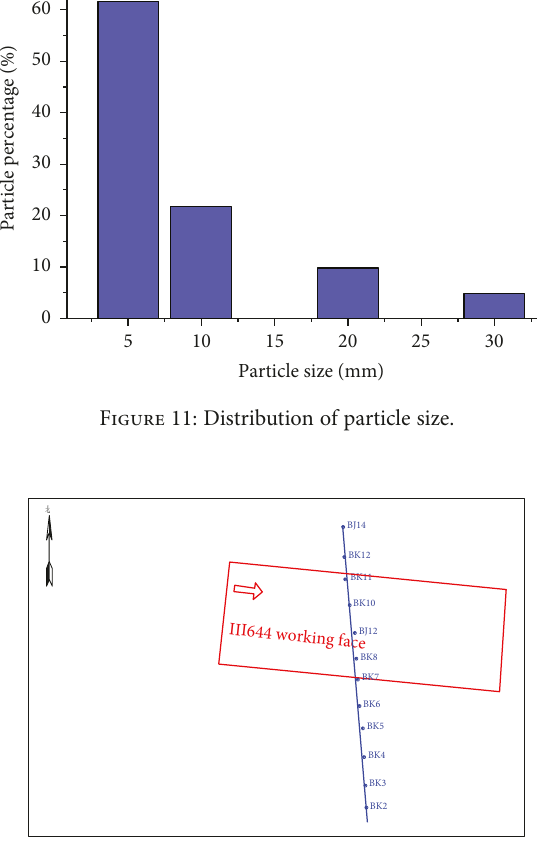
Figure 12: The contrast of the III644 working face and the observation station position.